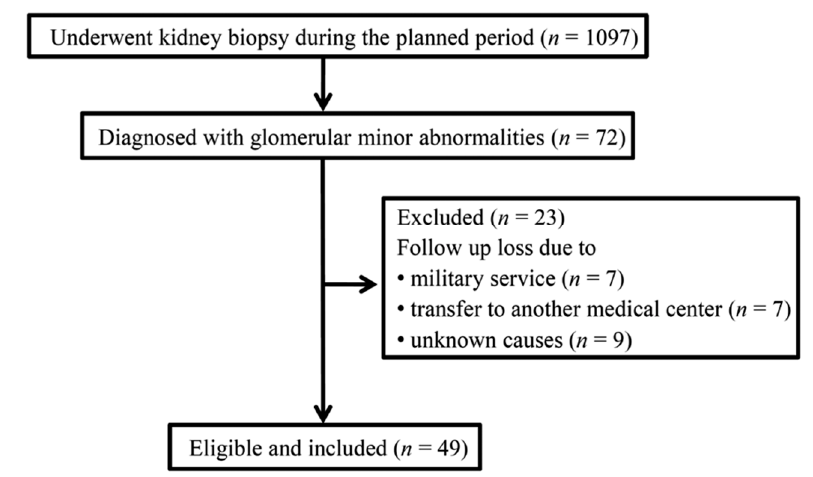
Figure 1. Study population for the retrospective study.